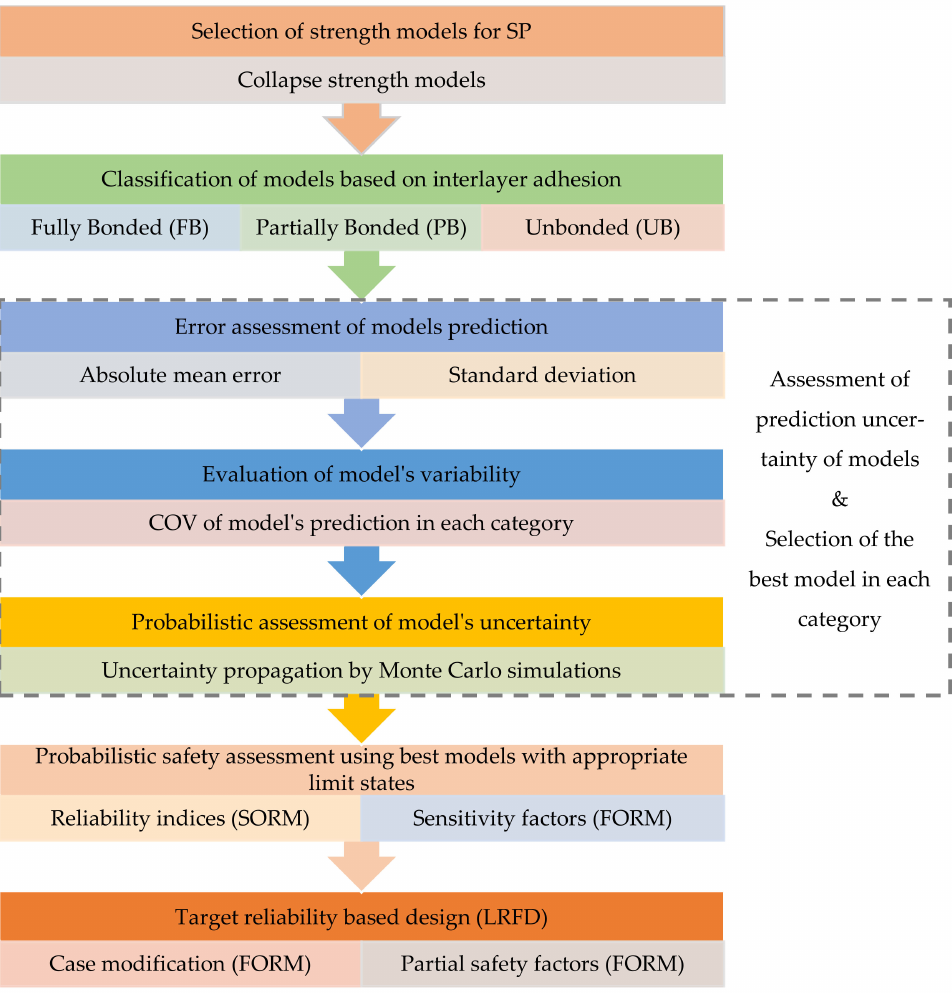
Figure 2. Outline of the main steps and sub steps in the proposed